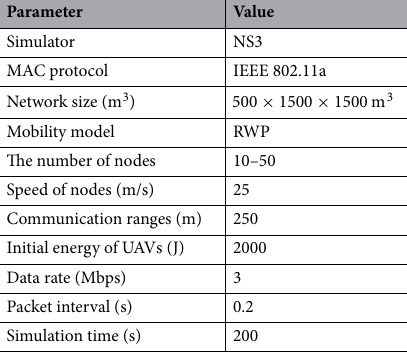
Table 4. Simulation